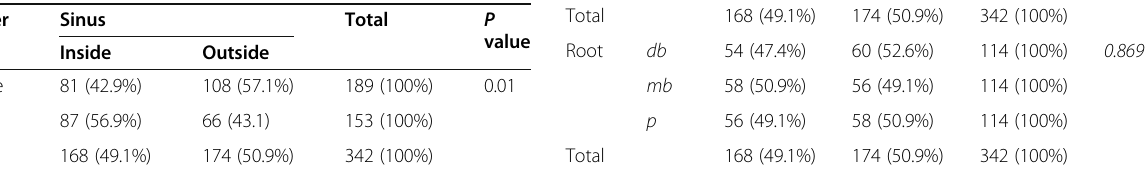
Table 2 The number and percentage of the roots intruding and extruding the sinus in each gender and its p value Gender Sinus Total P Inside Outside Female 81 (42.9%) 108 (57.1%) 0.01 Male 87 (56.9%) 66 (43.1) 153 (100%) Total 168 (49.1%) 174 (50.9%) 342 (100%)